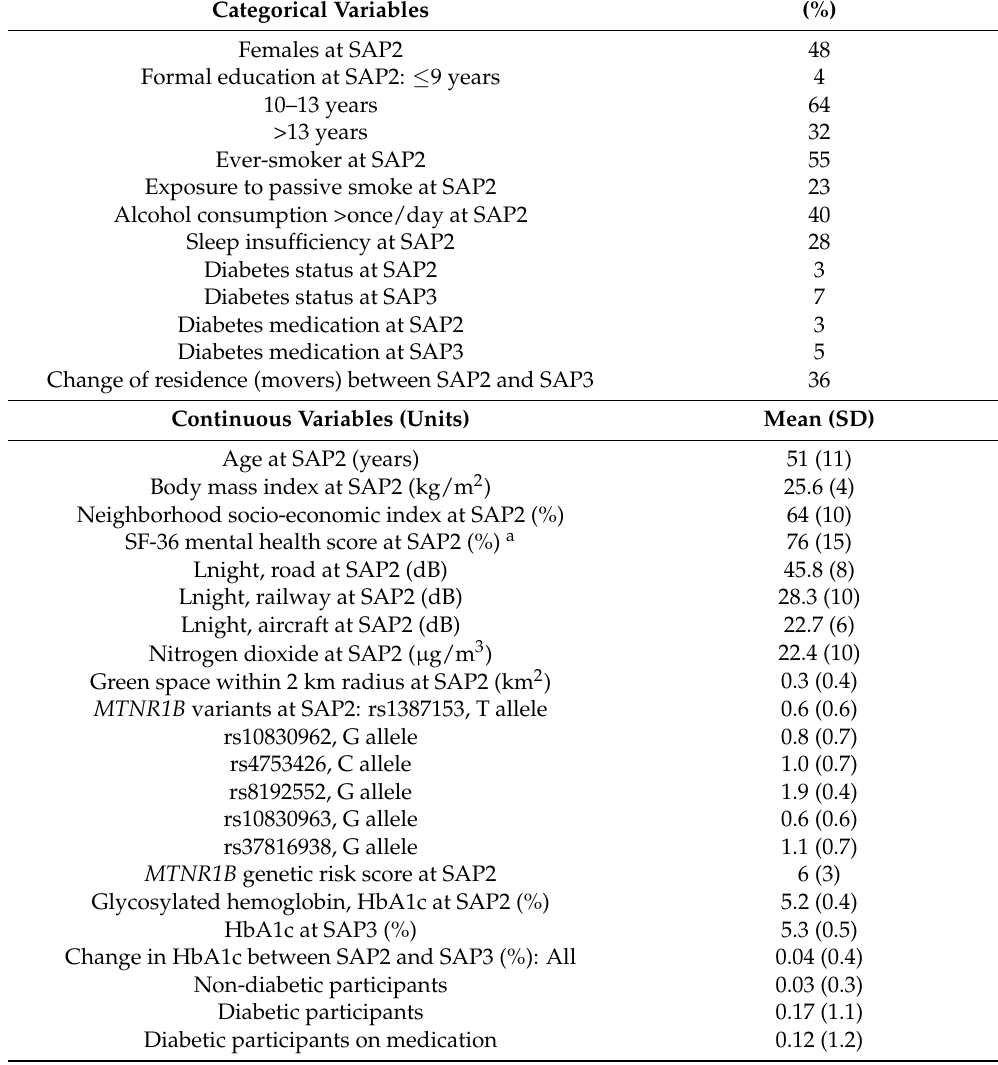
Table 1. Characteristics of study participants included in the